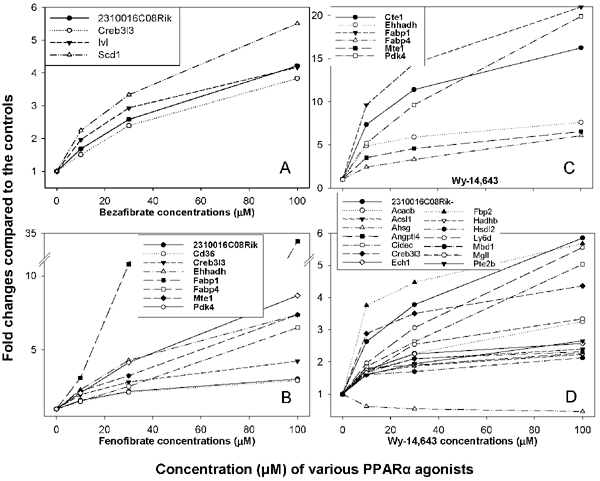
Dose-dependency of gene expression. Genes commonly regulated at low, middle and high dose levels were selected.